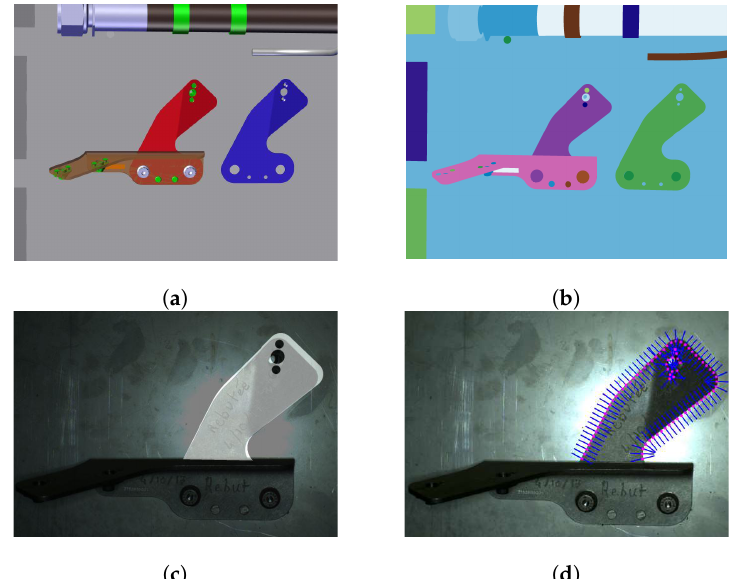
Figure 14. Occlusion handling by rendering using Color Rendering Index (CRI): ( a ) CAD model rendered with CATIA composer, ( b ) CAD model rendered using CRI, ( c ) mask generated using CRI render, white areas represent region to be inspected, and ( d ) filtered edgelets (Figure 11d) projected inside the region of interest specified by the generated